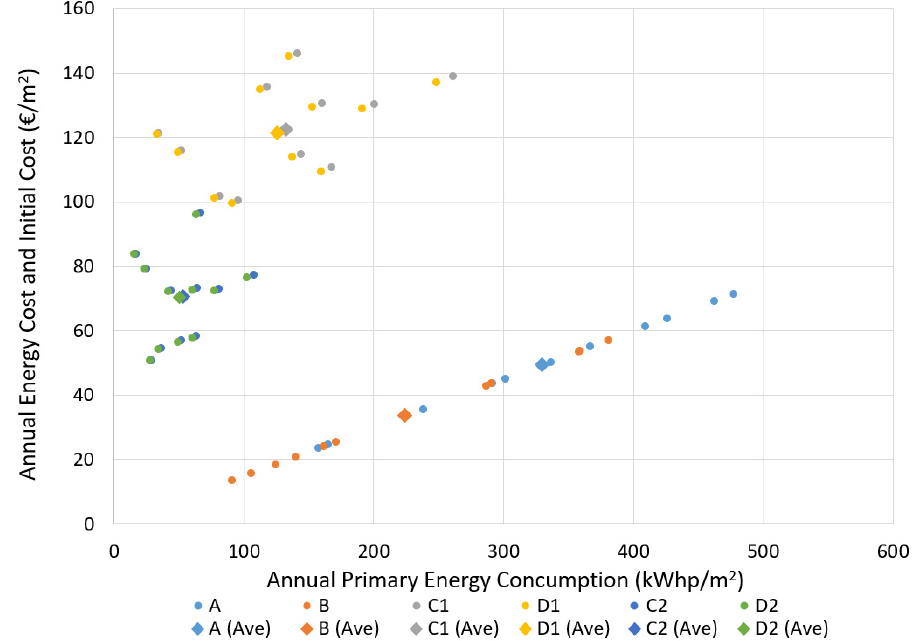
Figure 9. Annual energy cost and initial cost for LED luminaires versus the annual primary energy consumption per square meter of the entrance zone of the examined tunnels (11 tunnels in regards 6 scenarios with the corresponding average values per